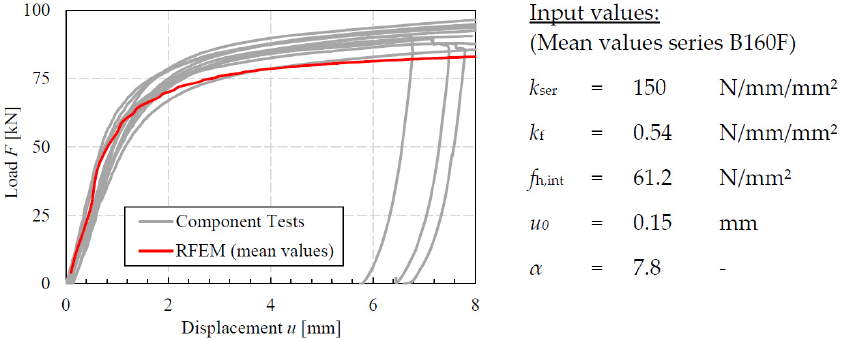
Figure 15. Experimental (“Component tests”) and numerical (“RFEM”) load–displacement curves of the test series with beech LVL [34].